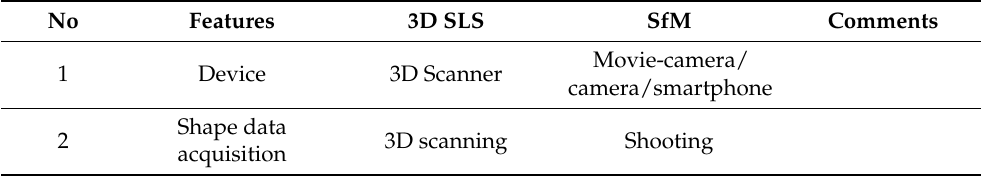
Table 2. Comparison of procedures for generating 3D models by the 3D SLS and SfM methods.